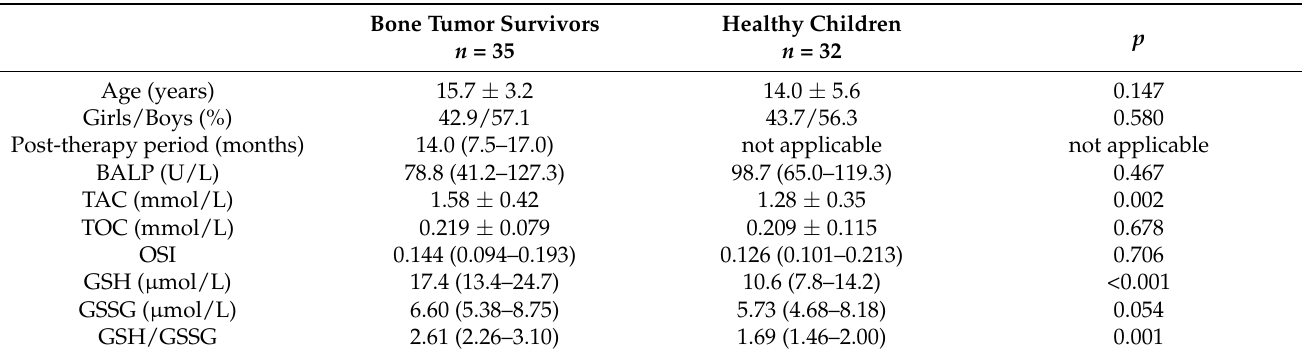
Table 2. Differences in biochemical parameters between bone tumor survivors (osteosarcoma, Ewing’s sarcoma) and healthy subjects.